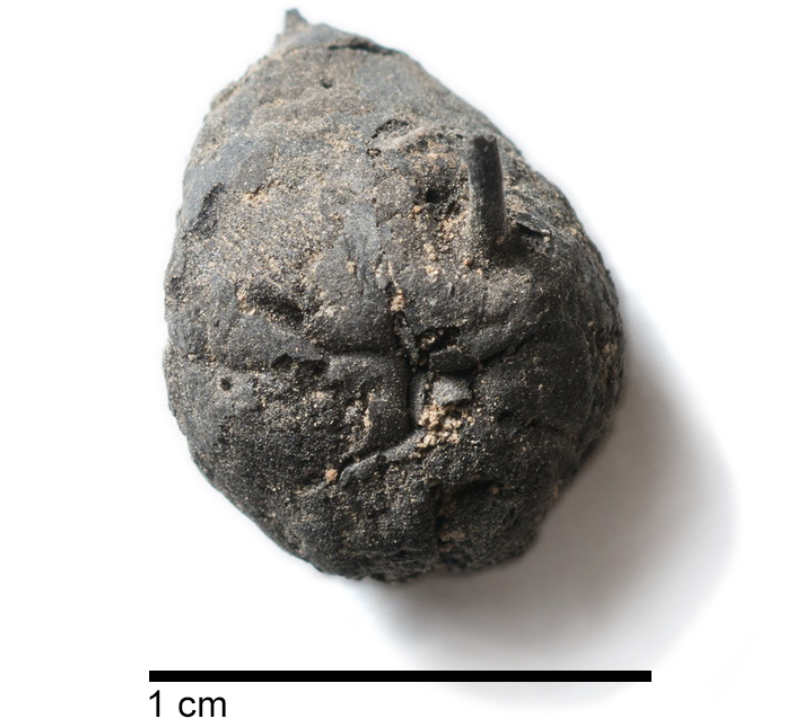
Figure 13: Charred Cyperaceae rhizome tuber (plant storage organs) from Shubayqa